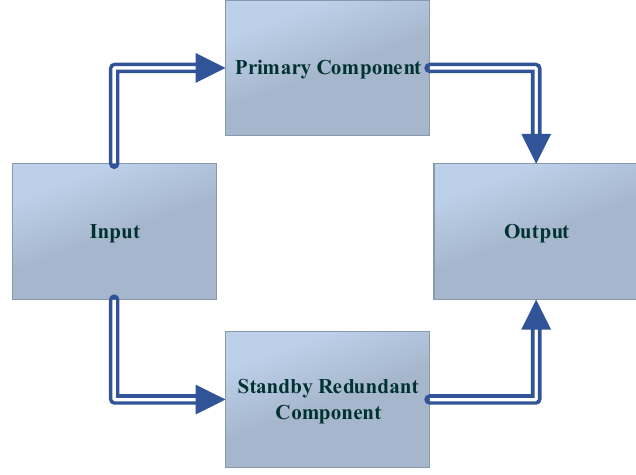
Figure 5. The dual redundancy [1].